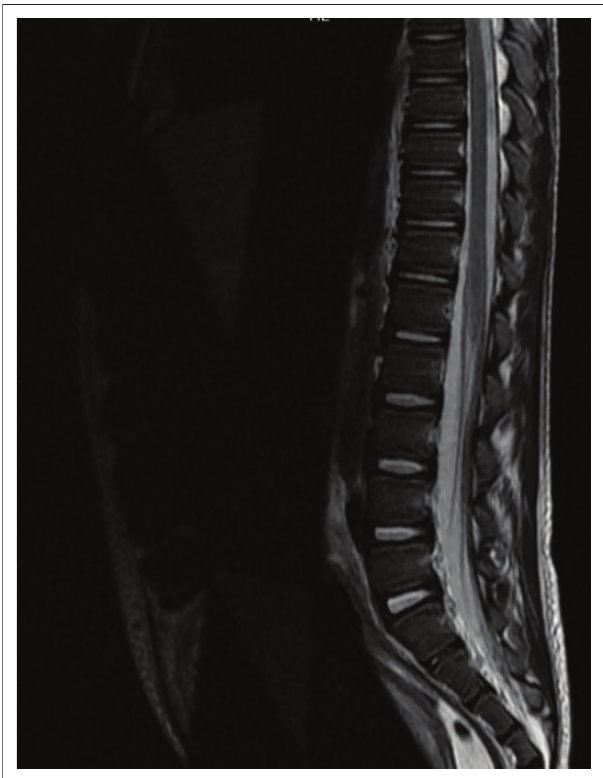
FIGURE 3: Sagittal T2-weighted magnetic resonance imaging sequence of the lower thoracic and lumbar spine demonstrating normal signal intensity in the spinal cord and conus medullaris.